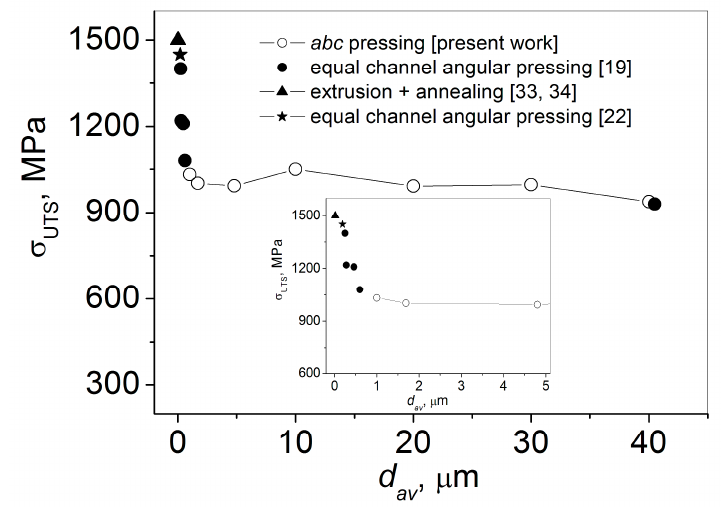
Figure 7. Ultimate strength versus average grain–subgrain size in Ti 49.8 Ni 50.2 exposed to different types of large plastic deformation.